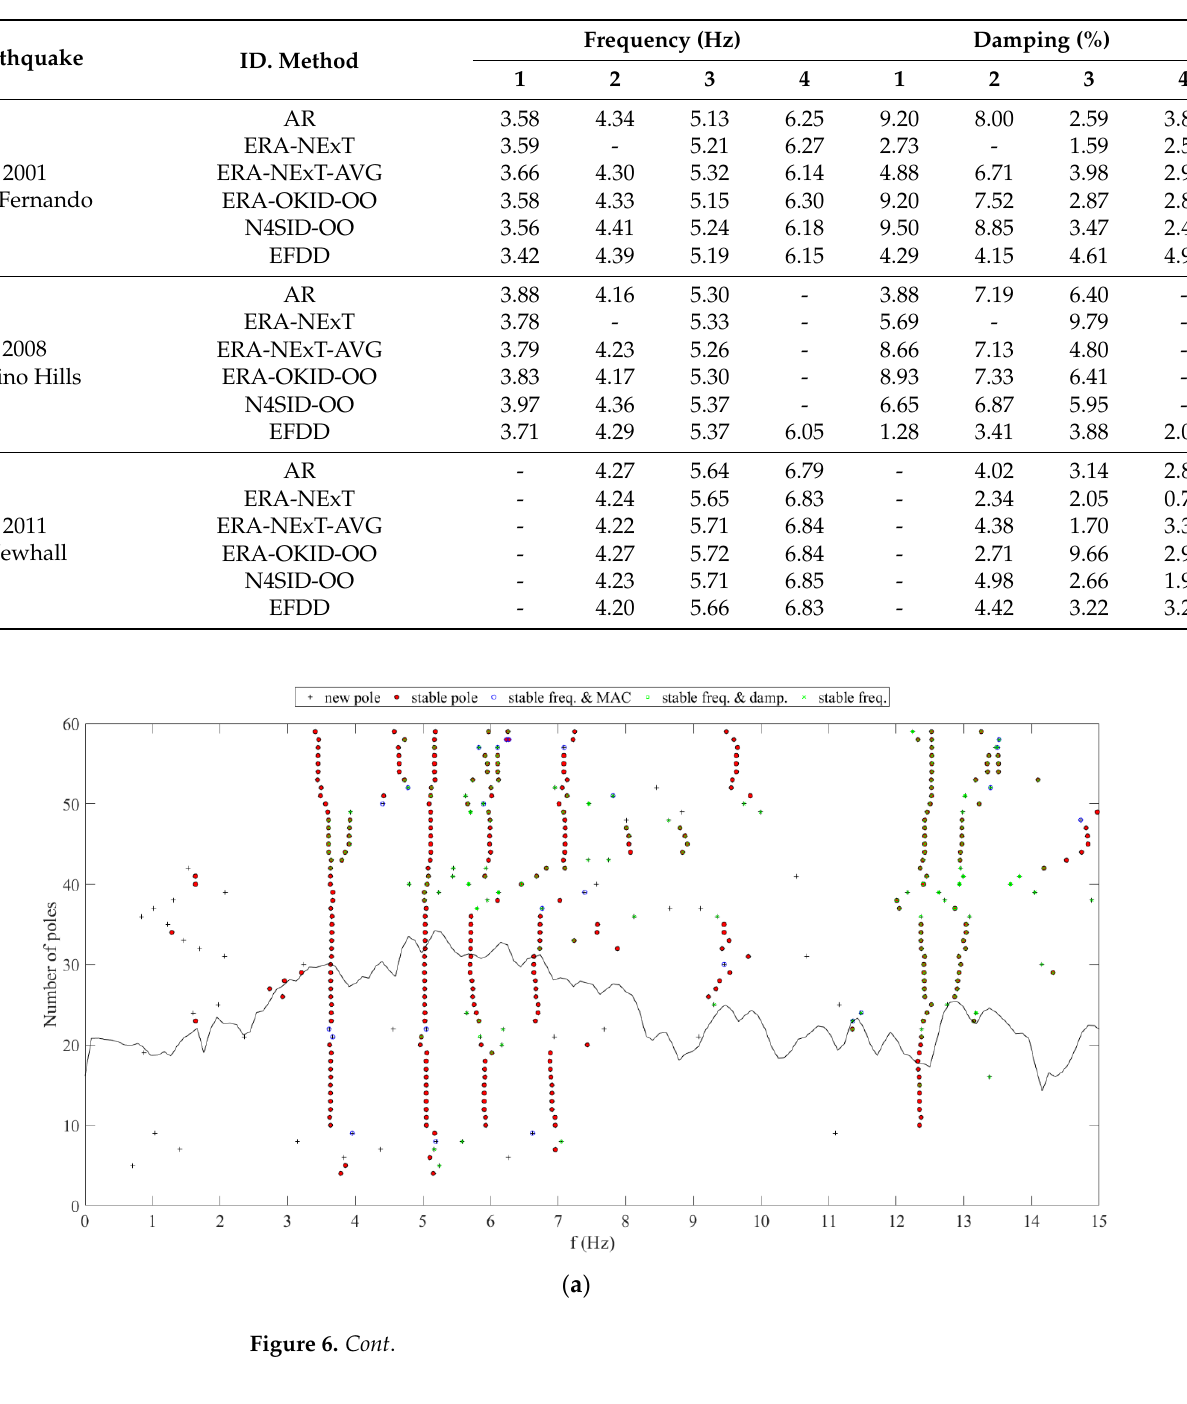
Table 5. Modal identification results of the identified frequency and damping using only seismic monitoring channel data of the dam body and the OO-type method.